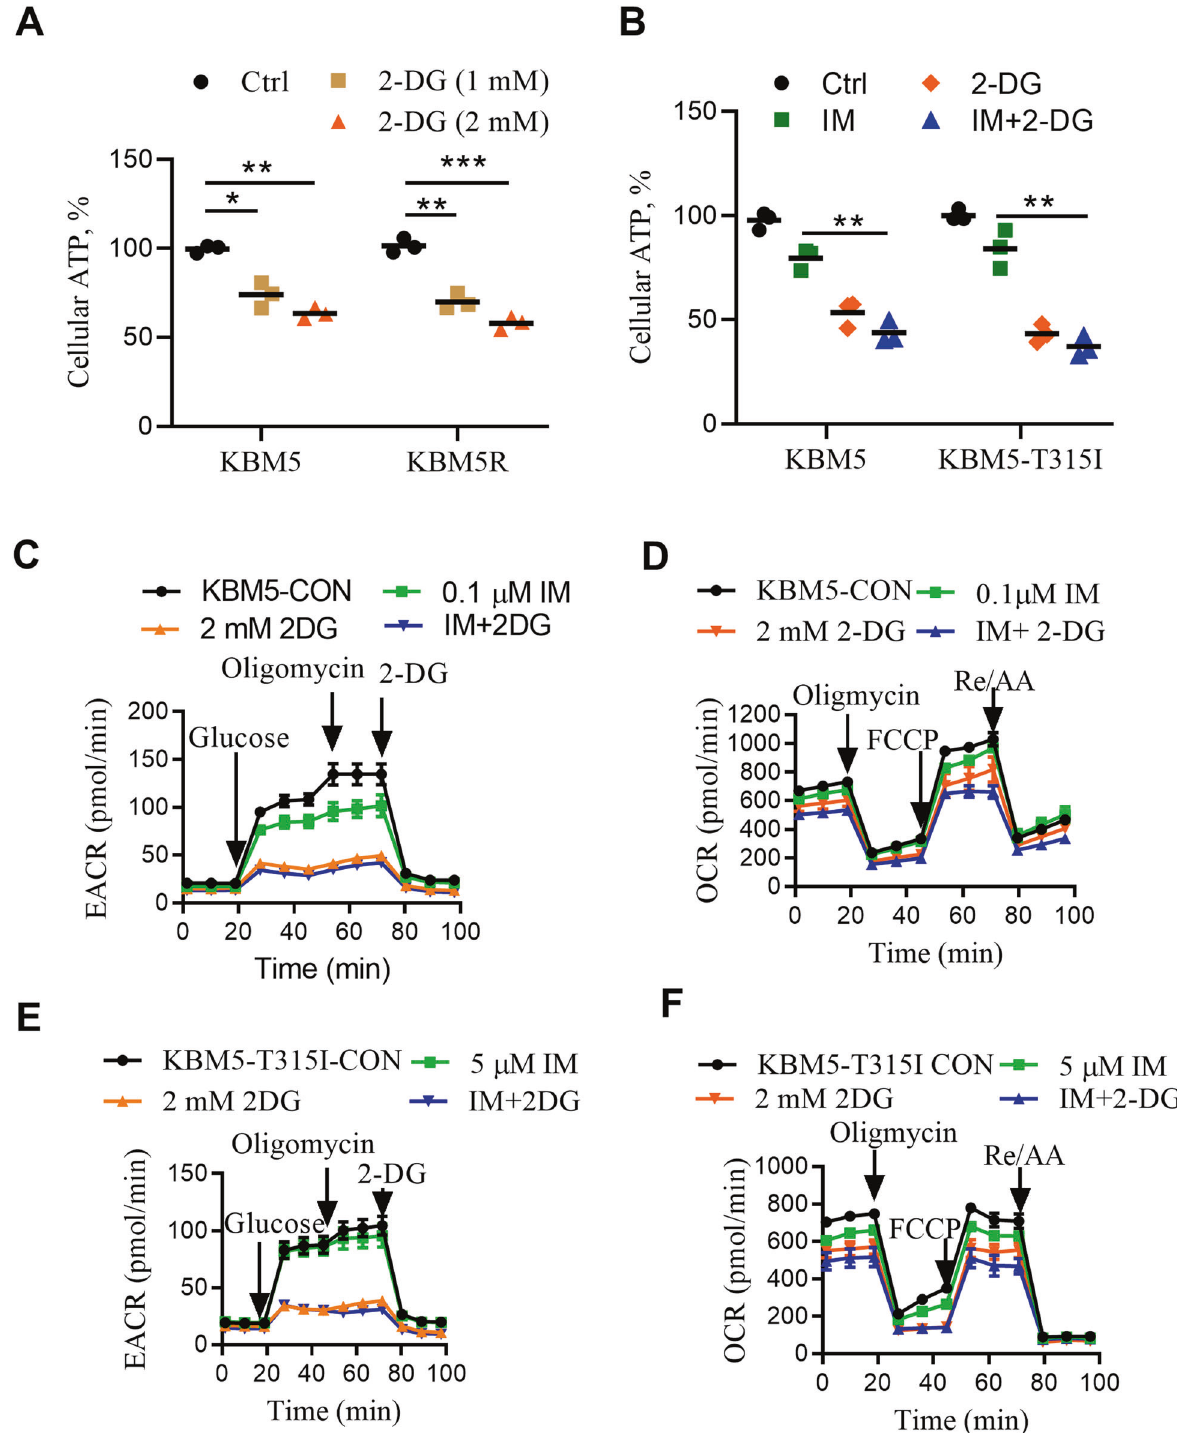
Fig. 4 Effect of 2-DG and imatinib on cellular energy metabolism. A KBM5 and KBM5-T315I cells were treated with 2-DG at indicated concentrations for 24 h, and intracellular ATP levels were measured. Each bar represents means ± SD, n = 3, * P < 0.05, ** P < 0.01, *** P < 0.001. B KBM5 and KBM5-T315I cells were treated with 2-DG (2 mM), IM (0.1 μ M for KBM5 cells and 5 μ M for KBM5-T315I cells) and their combination for 24 h, and intracellular ATP levels were measured. Each bar represents means ± SD, n = 3, ** P < 0.01. C – F Real-time measurement of OCR and ECAR in indicated conditions using the Seahorse Bioscience Extra Cellular Flux Analyzer. For the glycolysis analysis ( C , E ), cells were fi rstly treated with 2-DG (2 mM), IM (0.1 μ M for KBM5 cells and 5 μ M for KBM5-T315I cells) and their combination for 6 h, and then cells were sequentially treated with glucose, oligomycin (O, 1 μ M), 2-DG (1 μ M).For the mitochondrial function analysis ( D , F ), cells were fi rstly treated with 2-DG (2 mM), IM (0.1 μ M for KBM5 cells and 5 μ M for KBM5-T315I cells) and their combination for 6 h, and then sequentially treated with, oligomycin (O, 1 μ M), FCCP (F, 1 μ M) and rotenone/antimycin A (R/A, 0.5 μ M).